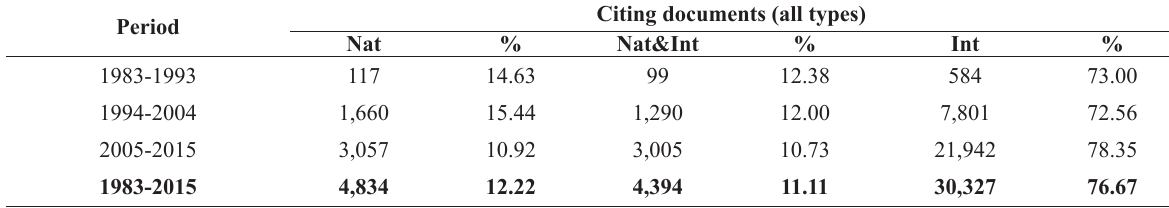
Summary of the main results for Brazilian HEP citations,